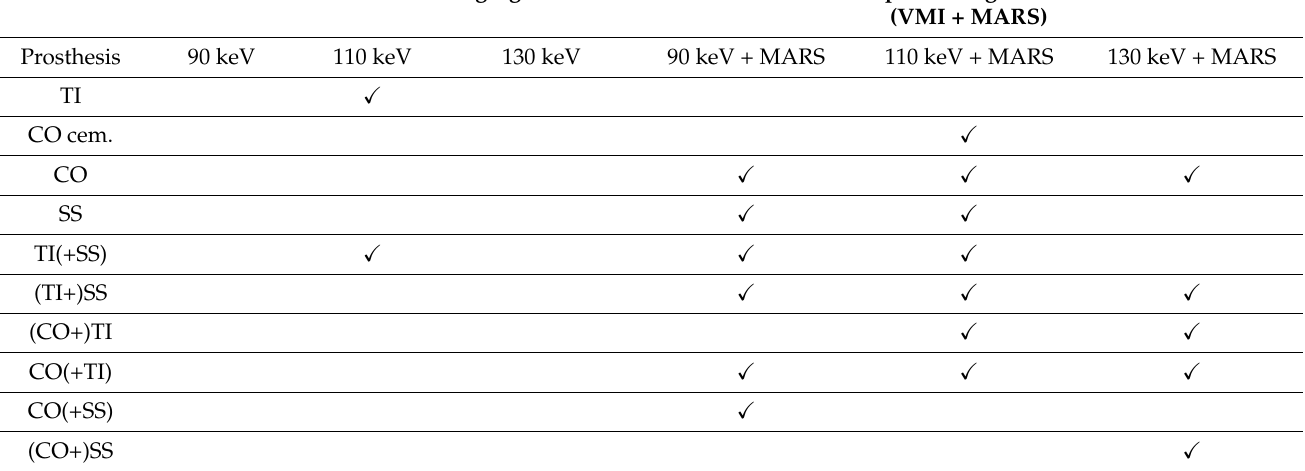
Virtual Monochromatic Imaging